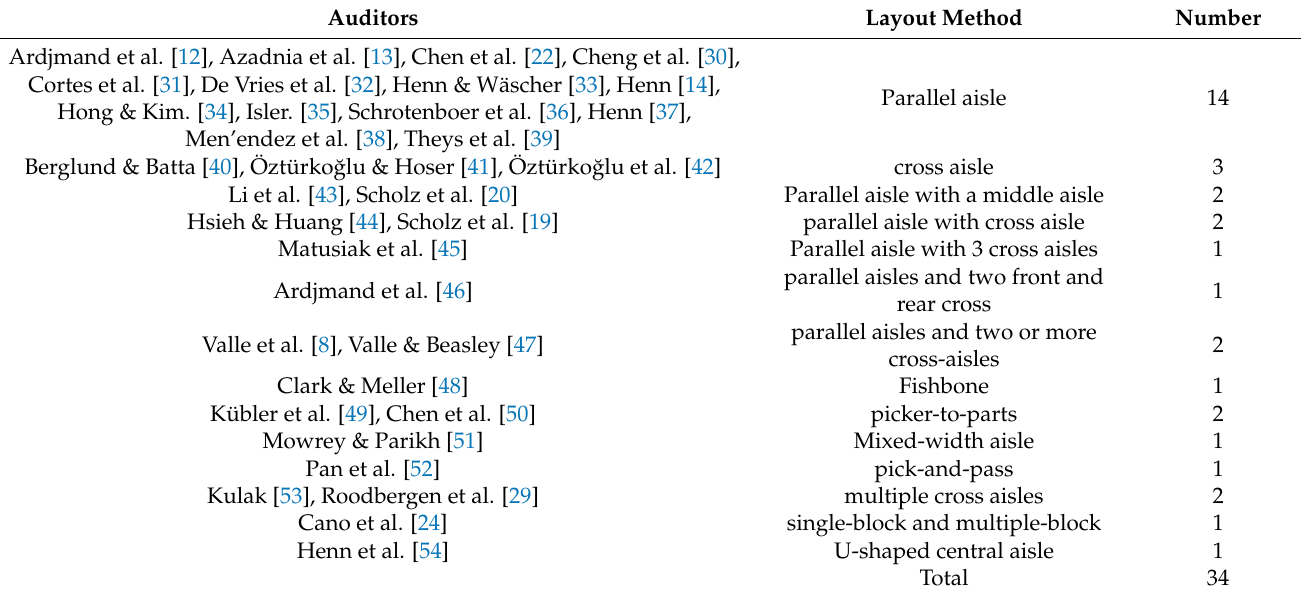
Table 2. Areas of study of warehouse layout types in